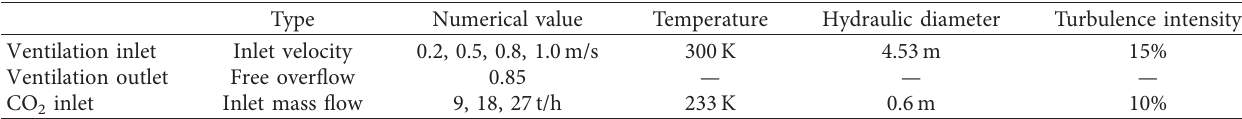
Table 5: Boundary control conditions of the